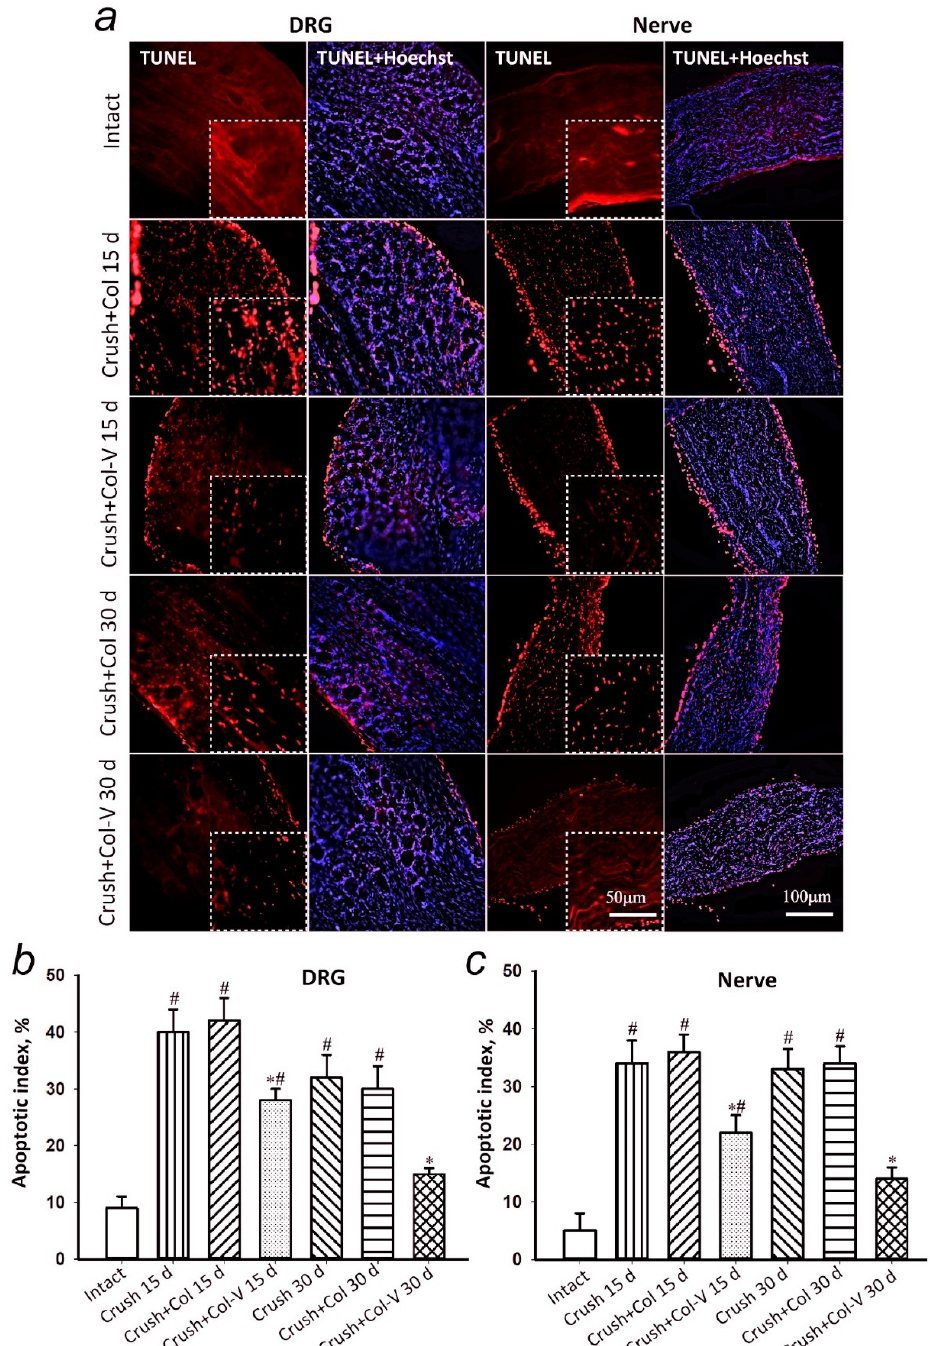
Figure 4. Apoptosis-level assessment in slices of the dorsal root ganglia and sciatic nerve. ( a ) Representative images of slices of the rat dorsal root ganglia (DRG) and a slice of the nerve (Nerve) at 0.5 to 1 cm from the crushing site, stained with TUNEL (red) and with both TUNEL and Hoechst 33342 (cell nuclei, blue) 15 and 30 days after the sciatic nerve crushing and application of gel-only application (Crush+Col) or gel–vesicle preparation (Crush+Col-V). Scale bar: 100 and 50 µm in the zoomed images. ( b ) Changes in apoptotic index in DRG. ( c ) Changes in apoptotic index in nerve slices. M ± SEM; n = 8 (mean apoptotic index in three DRG or nerve slices of eight animals of each experimental group); * p < 0.05 compared to the respective groups without vesicle treatment; # p < 0.05 compared to the intact nerve, One-Way ANOVA with Tukey’s post hoc test.